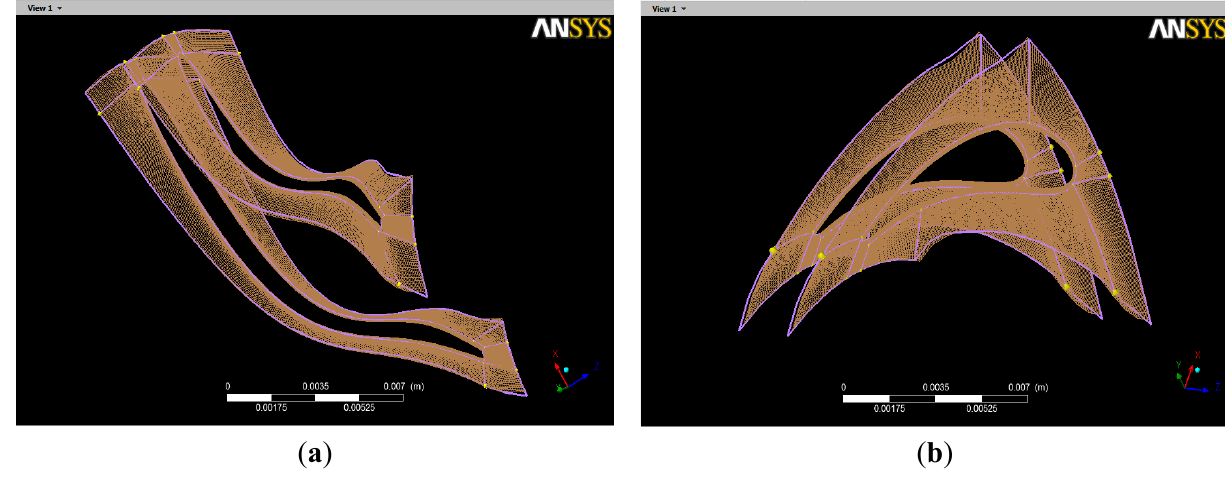
Figure 16. Rotor’s and stator’s vane